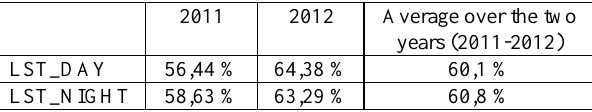
Table 2. Percentage of the number of cloudless days of the MODIS Terra product during the two years 2011 and 2012 All values used in this study are values which refer to cloudless